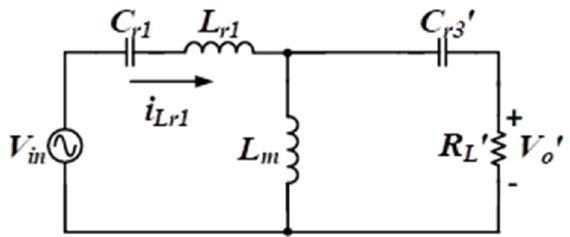
Figure 5. Equivalent circuit of a 2C2L resonant circuit in forward energy charging mode.